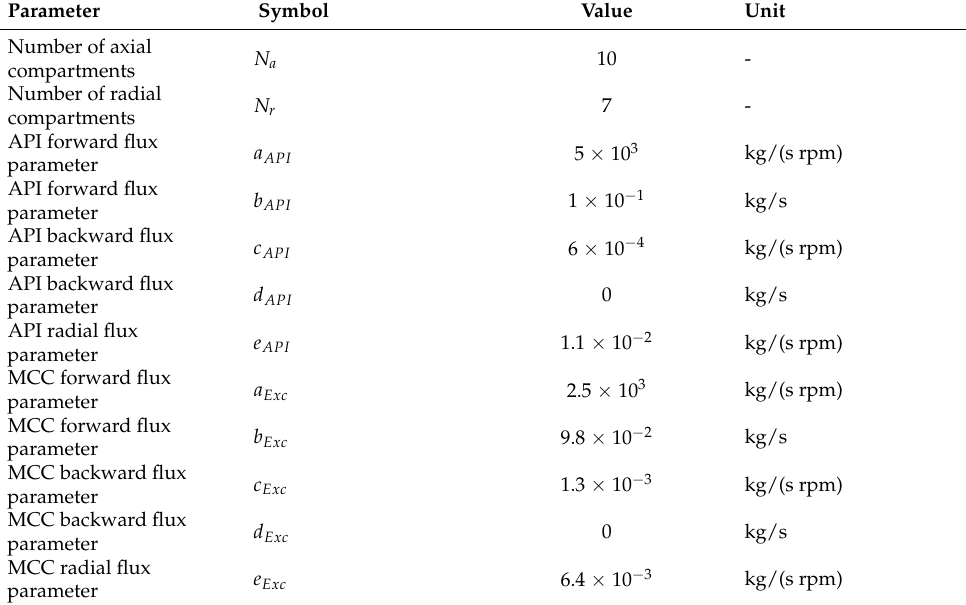
Figure 7. Example of simulator library modules for specifying the grain size in granulator unit. These are part of the process start-up settings given by the operator. All process parameters are detailed in Table 1. Table 1. Parameters for the blending process